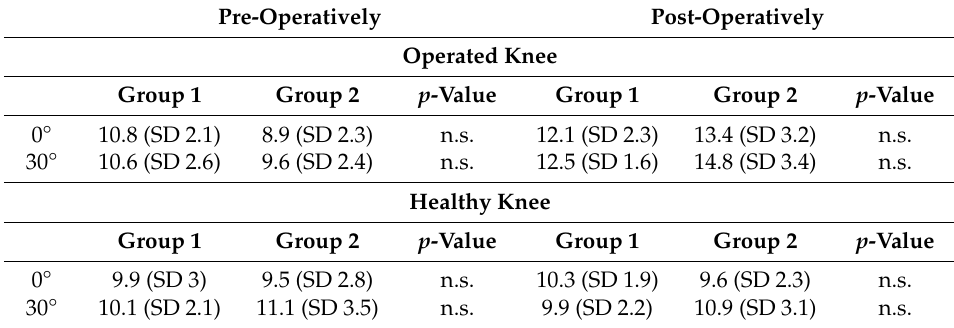
Table 2. Lateral knee compartment gapping (in millimeters) in a varus-stress radiograph in the operated and the healthy knees for both measurements: 0 ◦ and 30 ◦ of knee flexion. Not significant (n.s.) Pre-Operatively